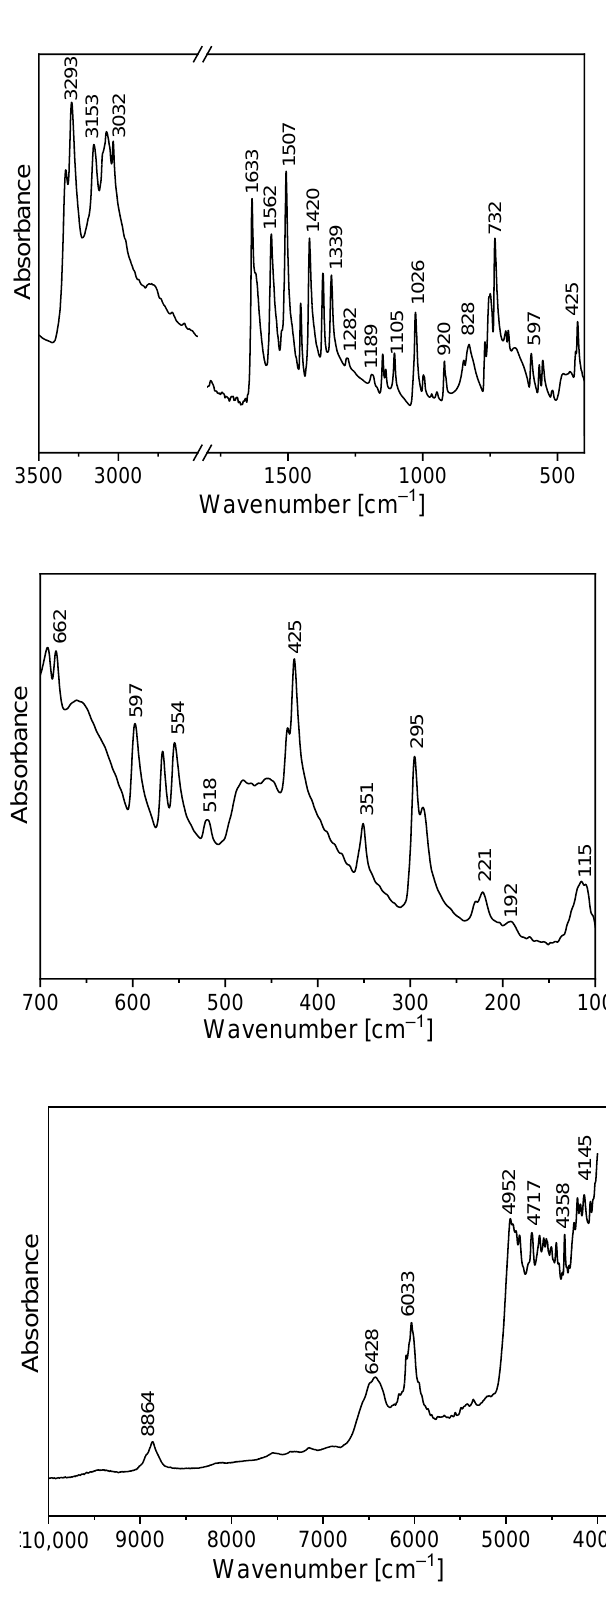
Figure 5. Infrared spectrum of TPa-NH 2 .